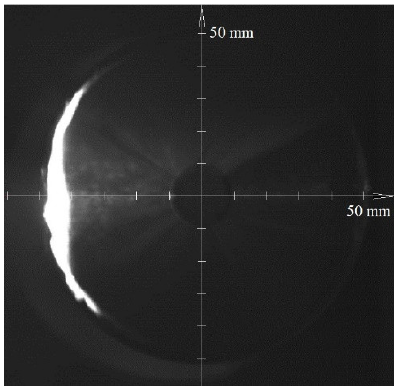
Figure 9. A section parallel to the partition with an orifice.